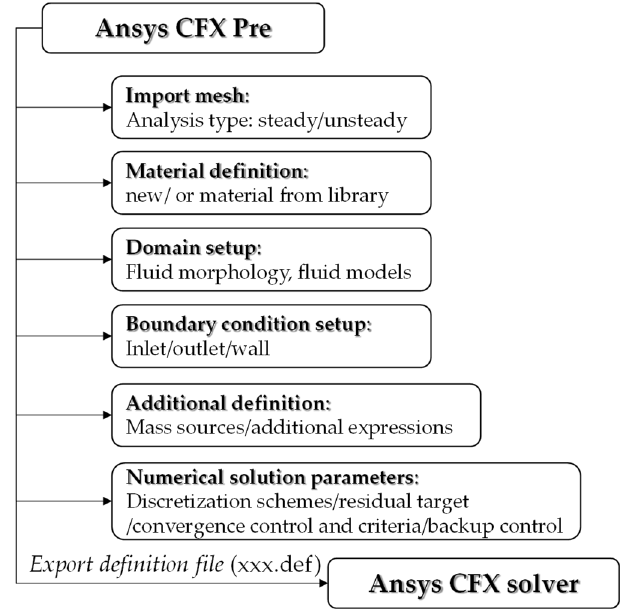
Figure 5. Flowchart of the pre-processing: definition of physical modeling and numerical parameters [27]. We created geometry by importing an existing DesignModeler in ANSYS package. Grid size of three-dimensional mesh was setup with 5